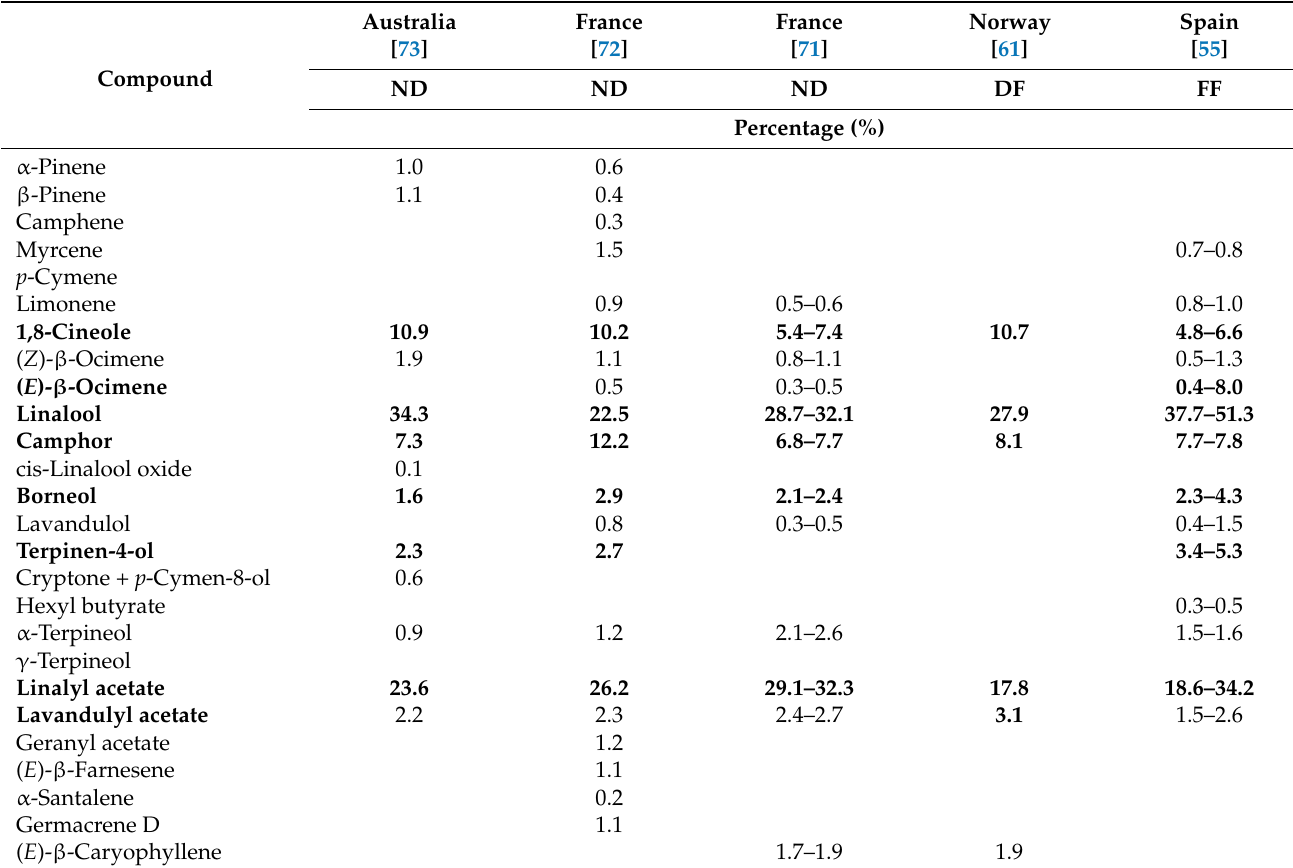
Table 6. Exemplary L. × intermedia ‘Grosso’ essential oil compositions from different